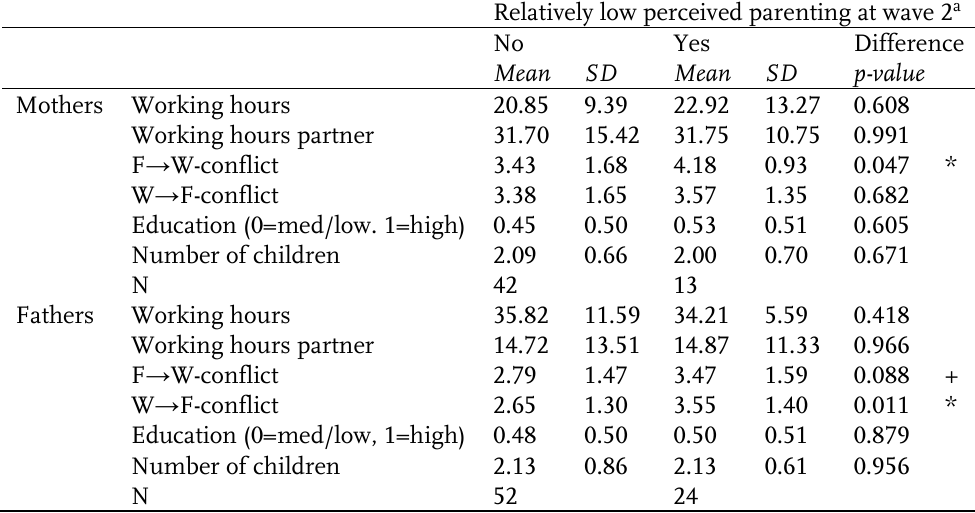
Table A.1 : Characteristics of those respondents who reported relatively low perceived parenting at wave 2 a